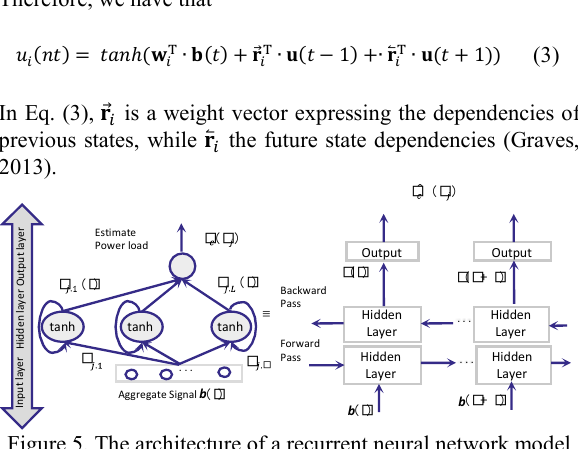
Figure 7. The architecture of the memory cell used in a bi- directional LSTM model (Kaselimi et al.,